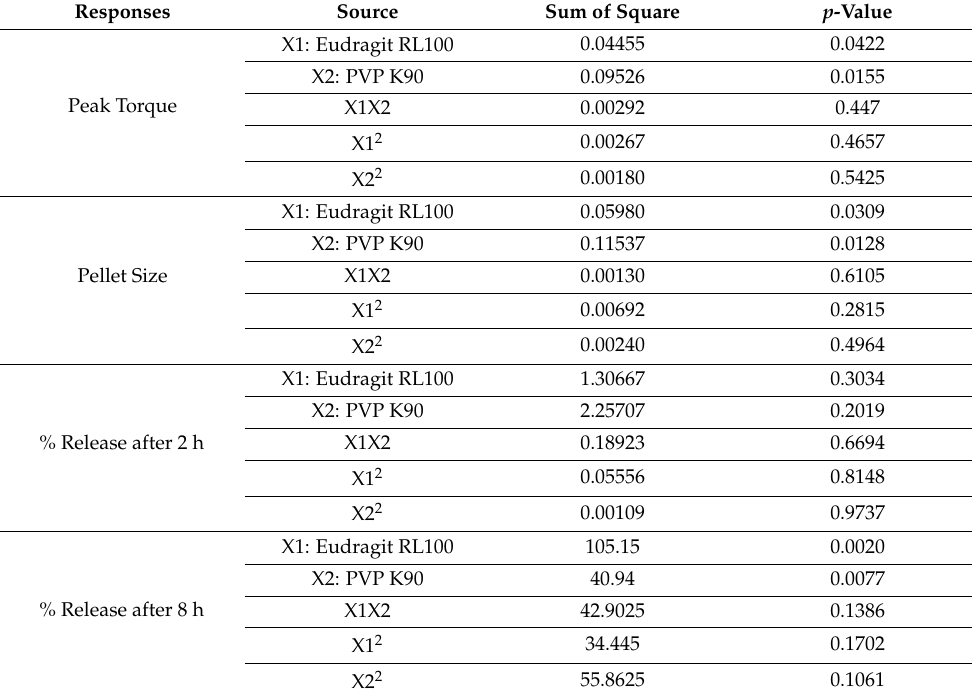
Table 2. Analysis of variance for the impact of Eudragit RL 100 and PVP K90 solution (independent factors) on the properties of AC sustained-release matrix pellet